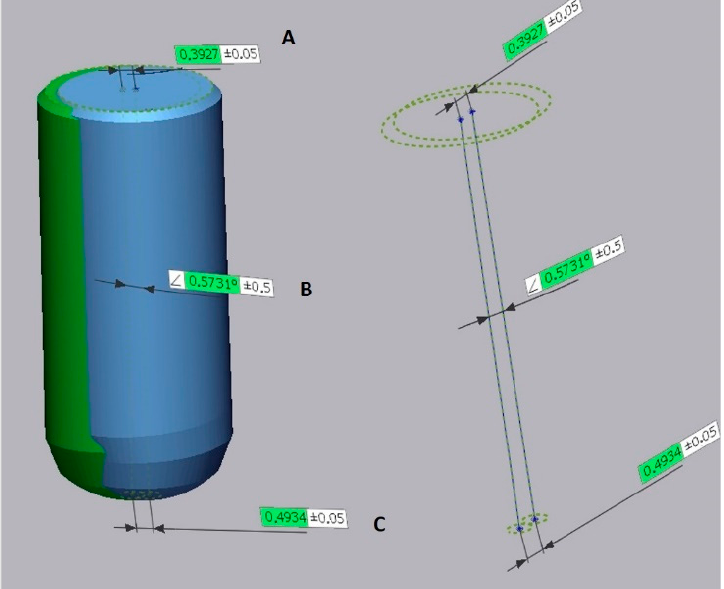
Figure 3. Representation of the outcome variables. A: Coronal deviation = distance between the centre of the neck of the planned implant and the centre of neck of the placed implant; B: Angular deviation = angle between the axis of the planned implant and the placed implant; C: Apical deviation = distance between the centre of the apex of the planned implant and the centre of apex of the placed